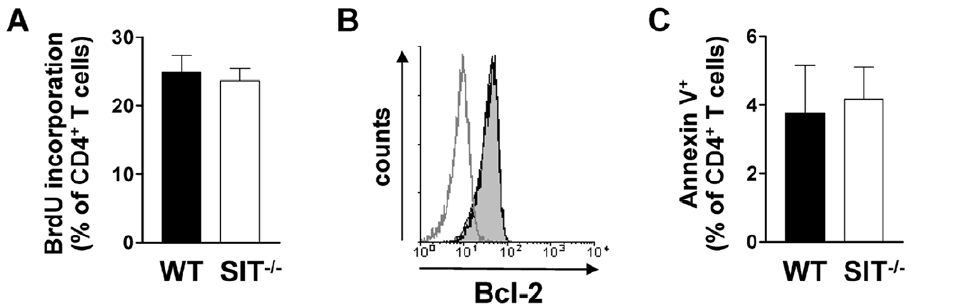
Figure 5. Normal survival and steady-state proliferation of SIT-deficient CD4 + T cells. Lymph node cells were isolated and stained with CD4 and CD8 mAbs. A) BrdU incorporation was measured for CD4 + T cells. Bar graphs indicate mean values 6 SEM from 3 SIT 2 / 2 and 5 SIT + / + mice. B) Intracellular Bcl-2 expression in CD4 + T cells from SIT 2 / 2 (empty histogram) and SIT + / + (filled histogram) mice. Isotype control is shown as a gray line. C) Annexin V expression on CD4 + T cells. Bar graphs indicate mean values 6 SEM from 3 SIT 2 / 2 and 3 SIT + / + mice.